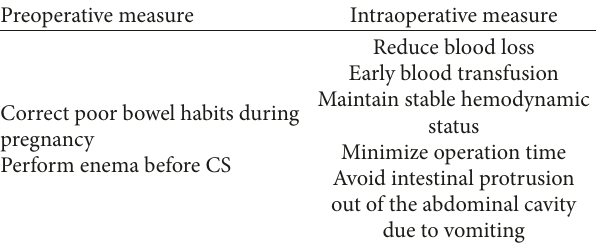
Table2:Pre-andintraoperativemeasurestakeninpregnantwomen to avoid adynamic ileus.